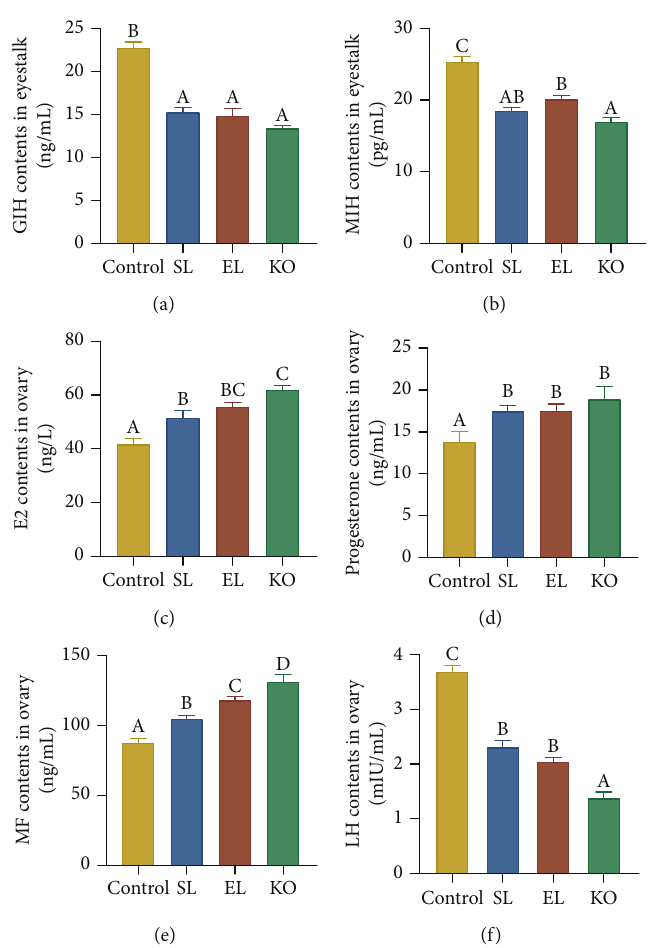
Figure 4: Gonad-inhibiting hormone and gonad-stimulating hormone concentrations in the eyestalk of C. quadricarinatus fed four diets with di ff erent phospholipid sources for 10 weeks. (a) Gonad-inhibiting hormone and (b) molt-inhibiting hormone concentration in the eyestalks. (c) 17 β -Estradiol, (d) progesterone, (e) methyl farnesoate, and (f) luteinizing hormone concentrations in the ovary. Data are expressed as the mean ± SEM (standard error of the mean) ( n = 4 , replicate tanks). Di ff erent uppercase letters (A, B, and C) indicate signi fi cant di ff erences ( P < 0 : 05 ) ( C > B > A ). GIH = gonad-inhibiting hormone; MIH = molt-inhibiting hormone; E2 = 17 β -estradiol; MF = methyl farnesoate; LH = luteinizing 20:5/20:5), and TG (22:0/18:3/16:0). (Figure 7). Heatmaps were